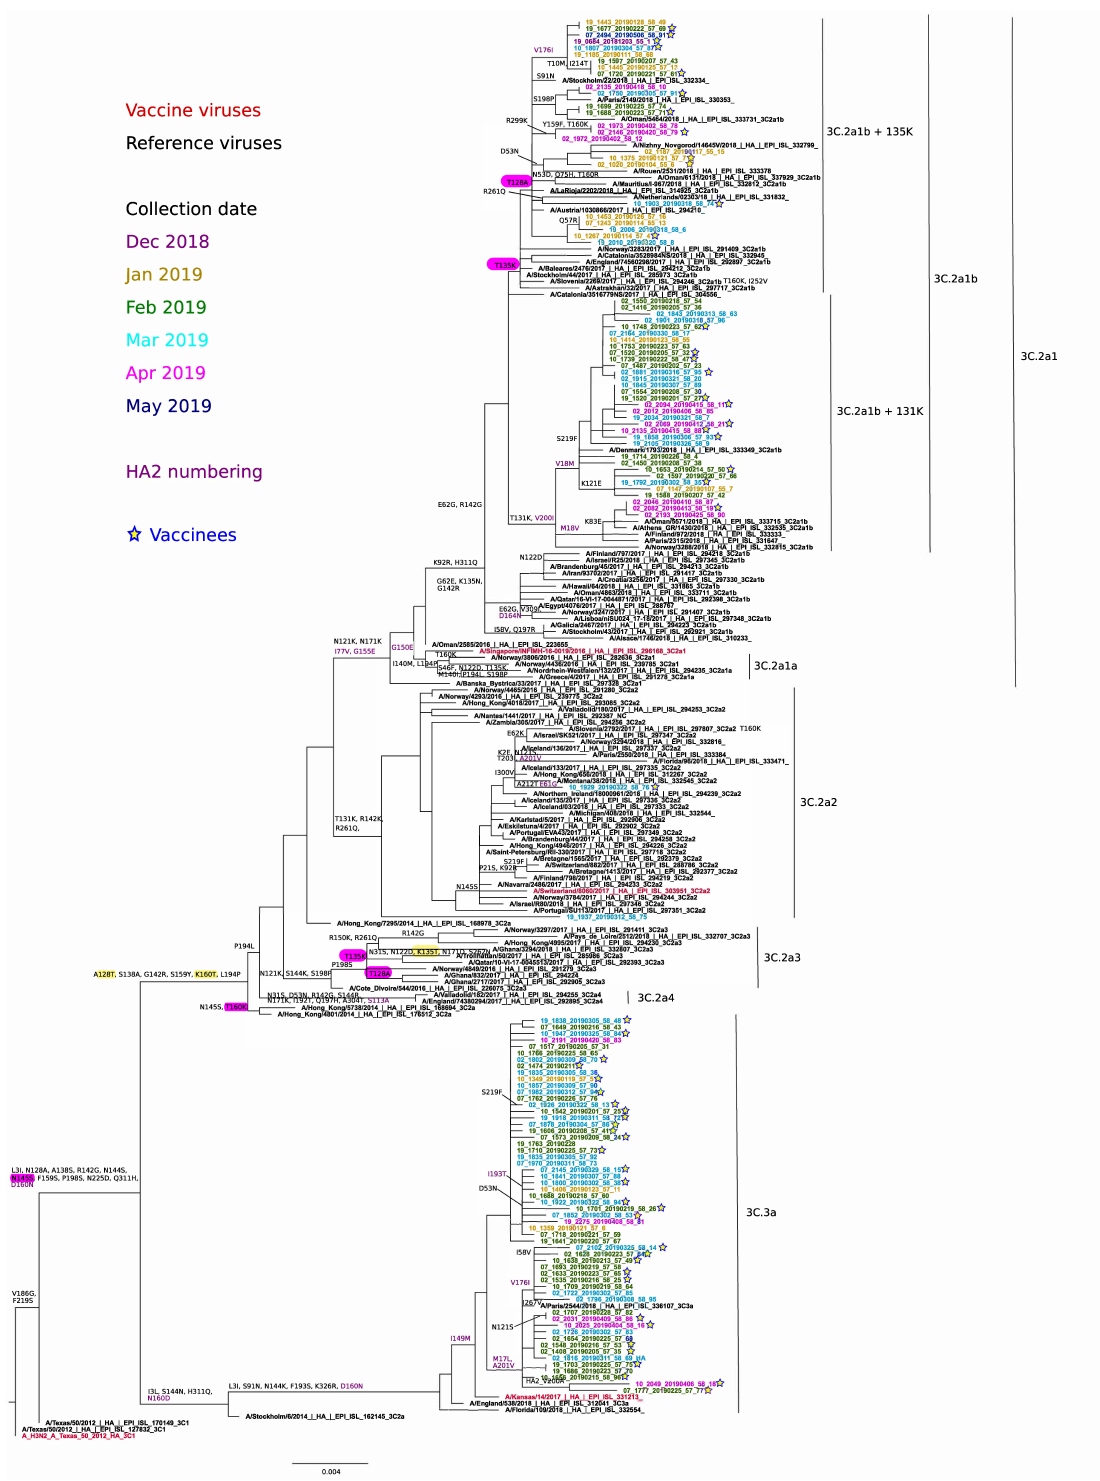
Figure 4. Phylogenetic analysis and mutational profiles for the A/H3N2pdm09 clades and sequenced isolates. Changes potentially gaining a glycosylation site are indicated in yellow, whereas those potentially losing a glycosylation site are indicated in red. ML tree constructed using RAxML (GTR-GAMMA substitution